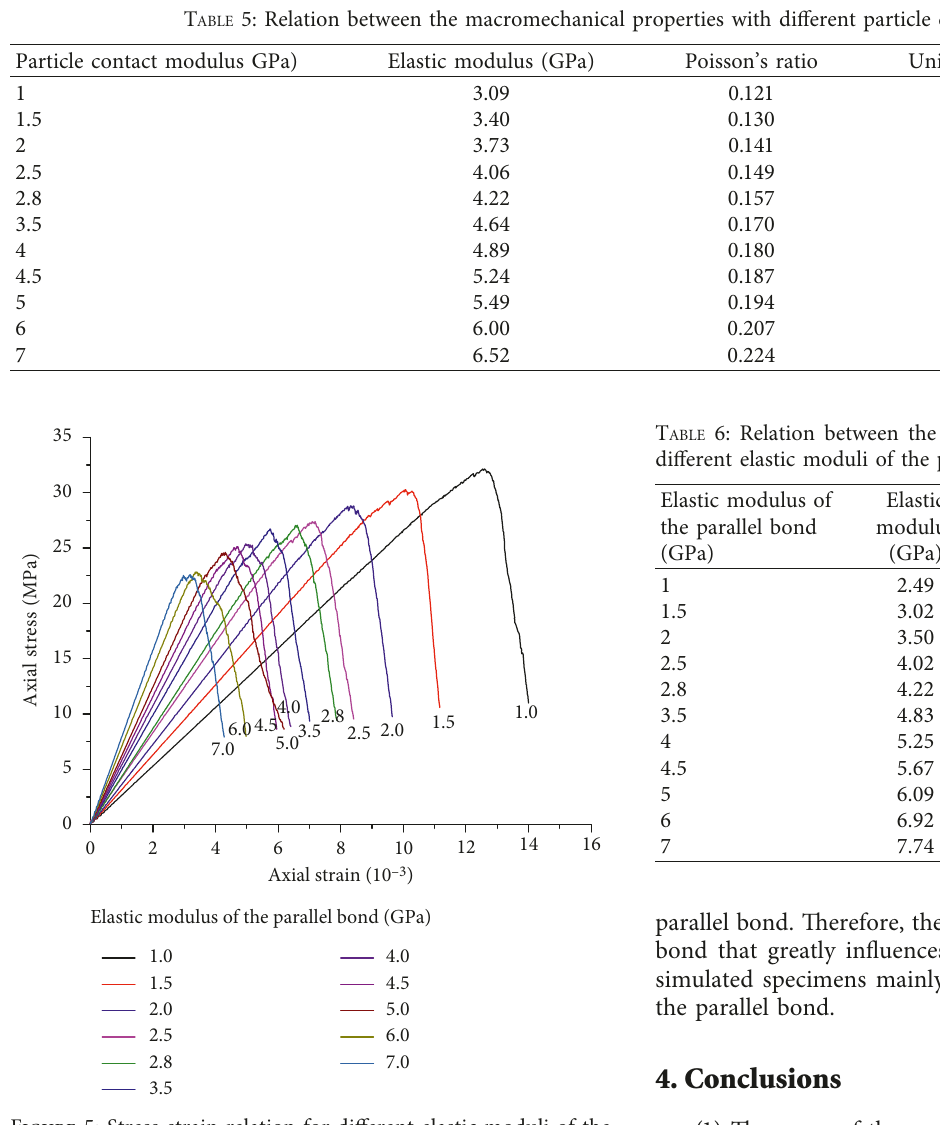
Figure 5: Stress-strain relation for different elastic moduli of the parallel bond.